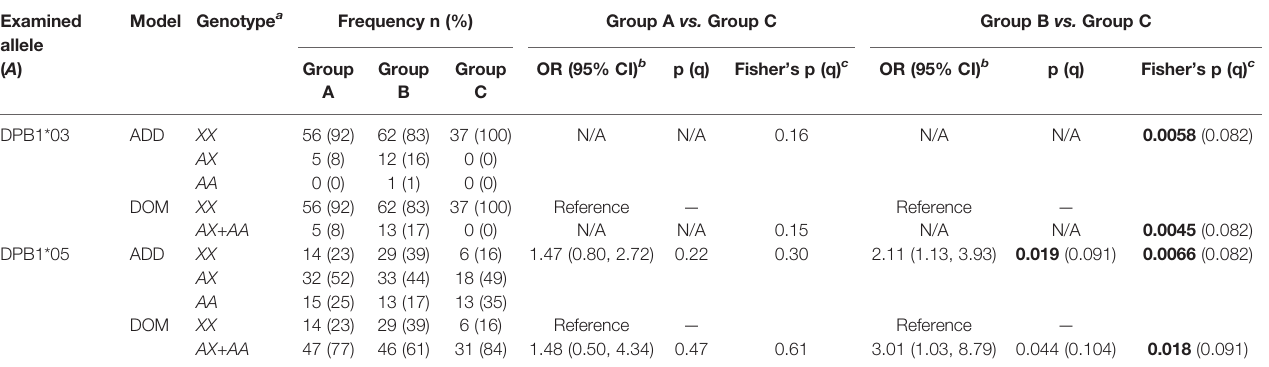
TABLE 3 | Signi fi cant associations of DPB1 alleles with effects of the HBV